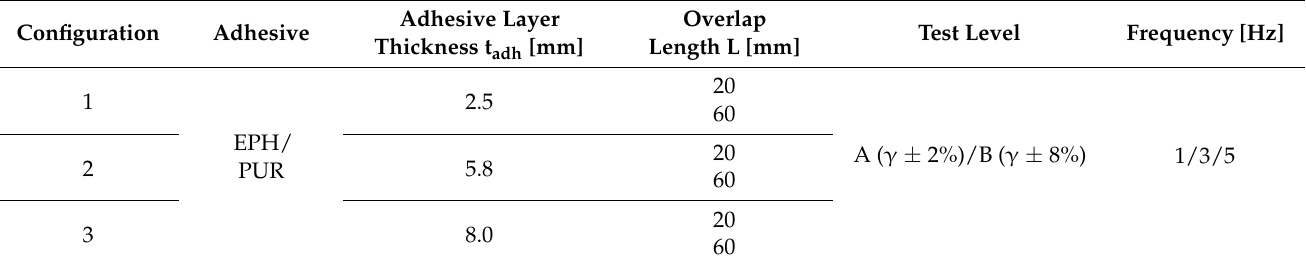
Table 1. Test parameters and test series of the experimental investigations of the damping behaviour of the adhesively bonded overlap joints based on [22].